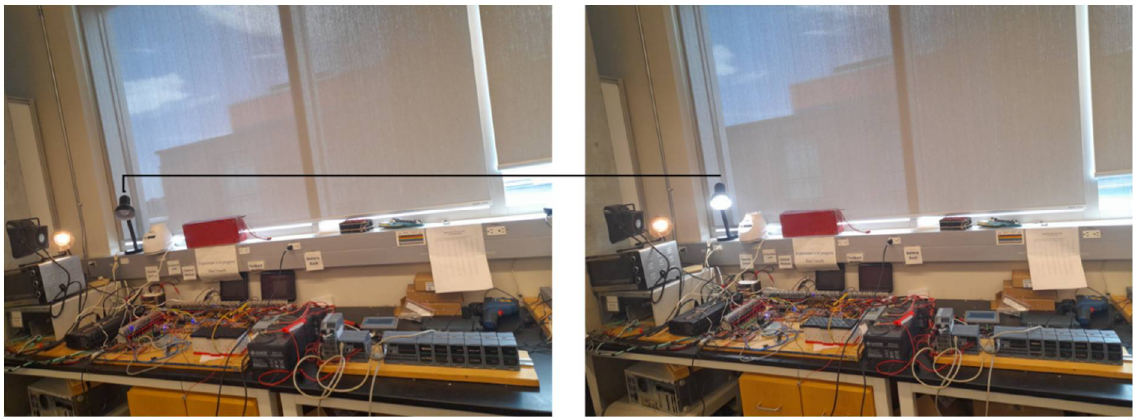
Figure 18. Fault tolerance test results of the microgrid.